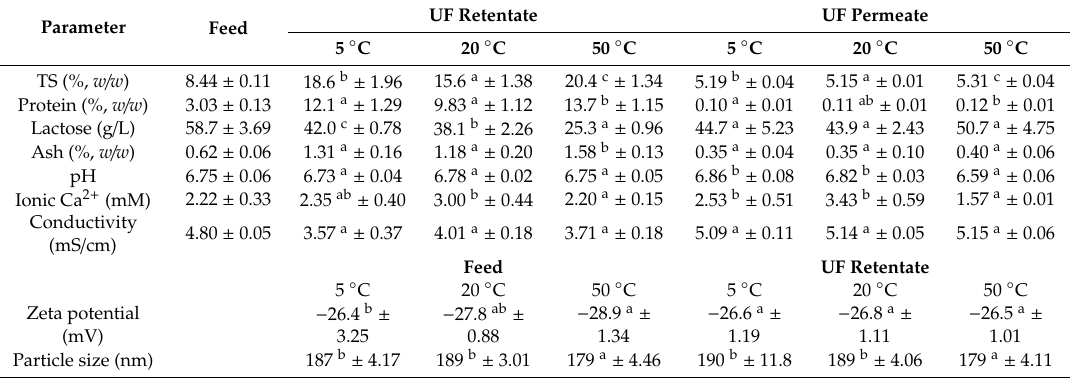
Table 1. Composition and physicochemical properties of retentates and permeates obtained by